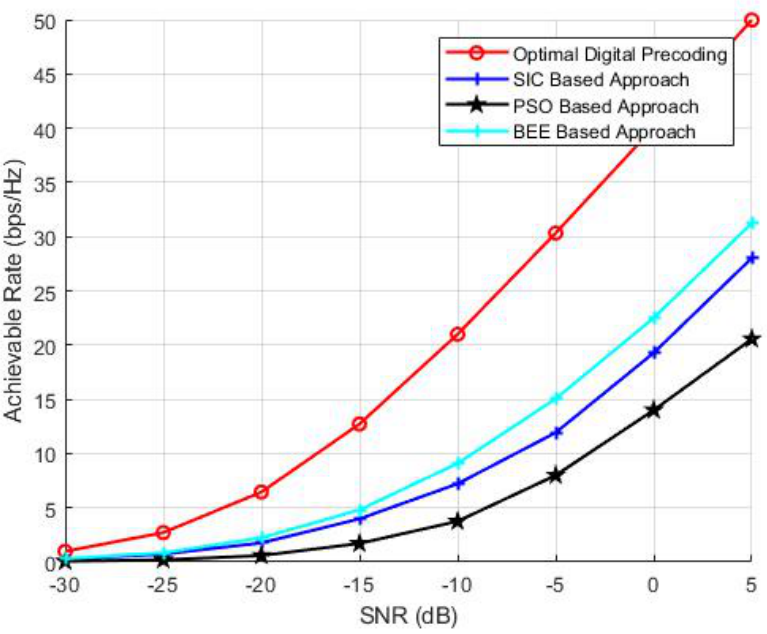
Figure 7. Simulations using N T = 144, N R = 36, N rf =